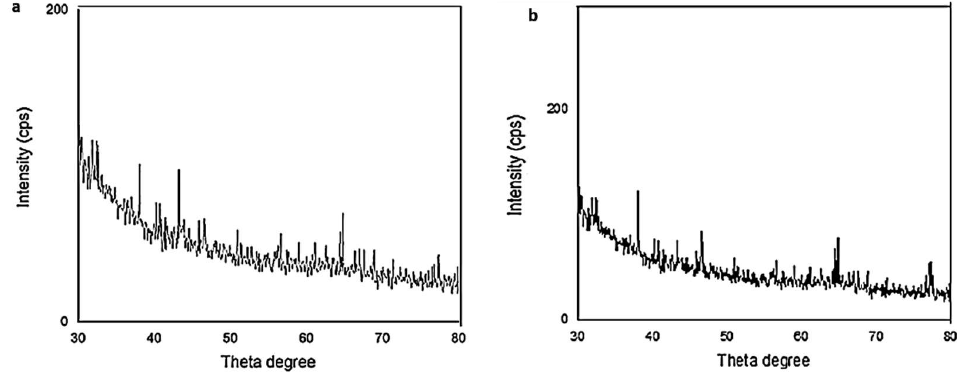
Figure 4. X-ray diffraction patterns of the silver nanoparticles prepared with CE ( a ) and EE ( b ).